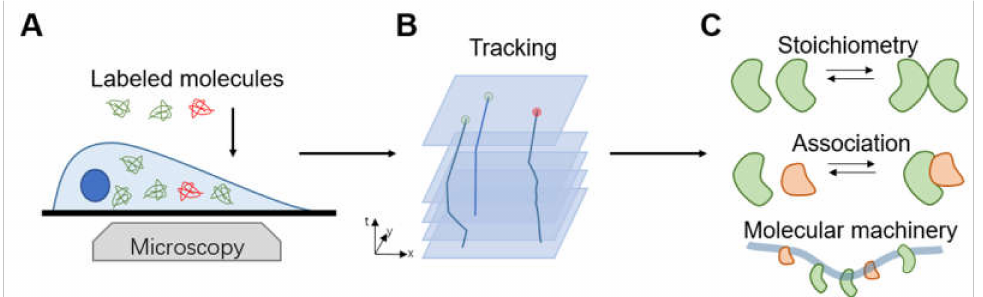
Figure 9. Work flow and applications of smFRET in single-molecule imaging in living cells. ( A ) The selection of appropriate fluorescent probe and dye pair is the primary critical step. Then the biomolecules are imaged using an optical fluorescence microscope with ultrahigh resolution and monomolecular sensitivity. ( B ) Single-molecule localization and tracking algo- rithms are employed to determine the position and motion state of the labeled molecule. ( C ) smFRET has been successfully applied in multifarious biomedical